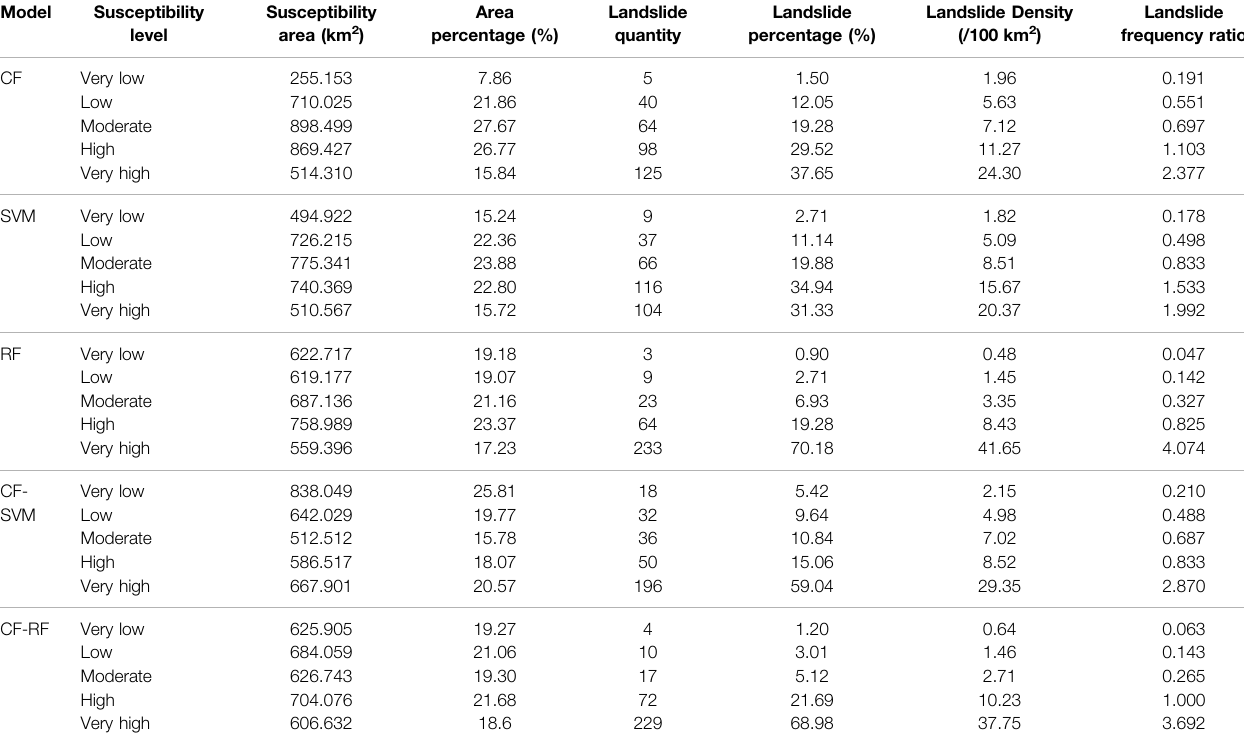
TABLE 6 | Comparison of the results of the different